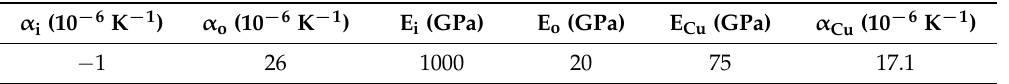
Table 2. Parameters used in this model [8].